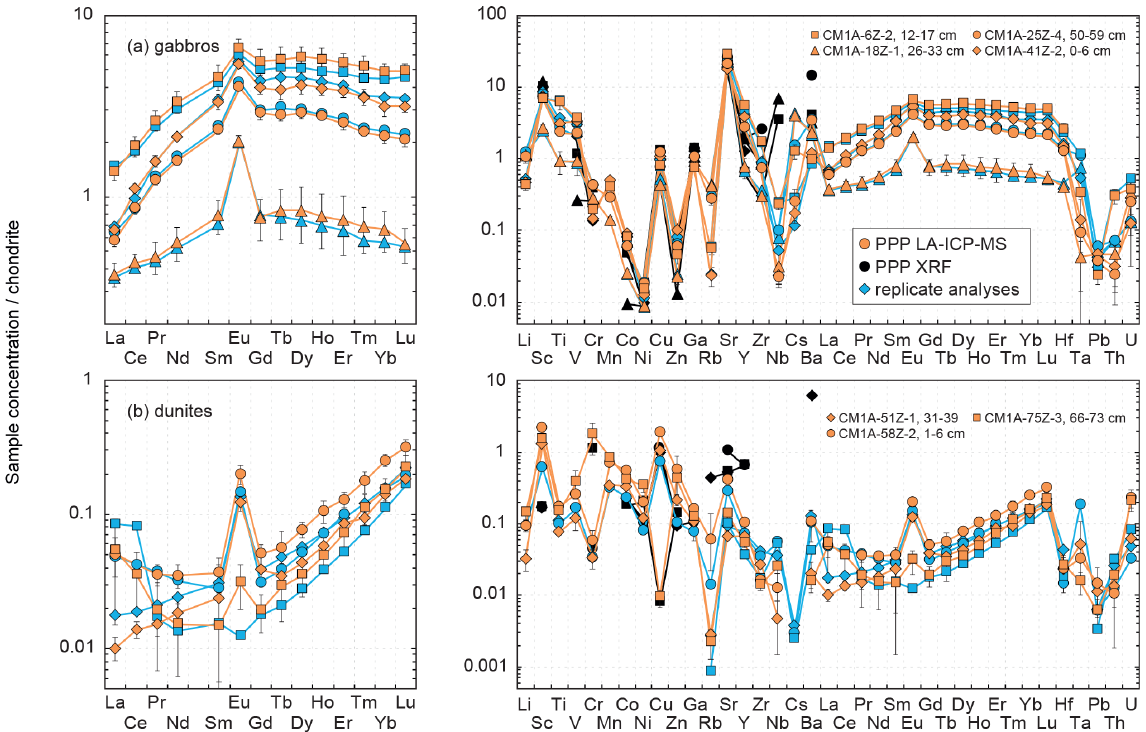
Figure 8. Chondrite-normalized (normalization values from Barrat et al., 2012) REE and multielement patterns obtained for the (a) gabbro and (b) dunite samples from Hole CM1A by LA-ICP-MS and XRF analyses of pressed powder pellets on-board the D/V Chikyu , compared to replicates for the same